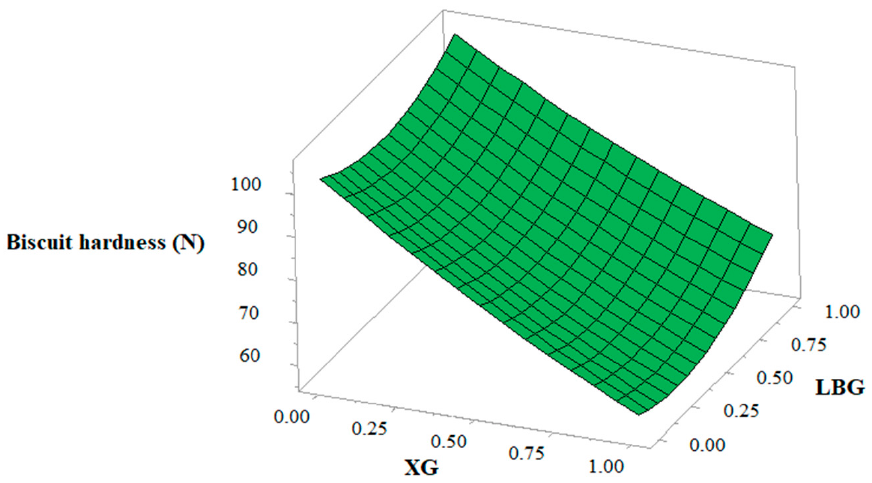
Figure 5. Response surface showing the effect of xanthan gum (XG) and locust bean gum (LBG) on biscuit hardness.